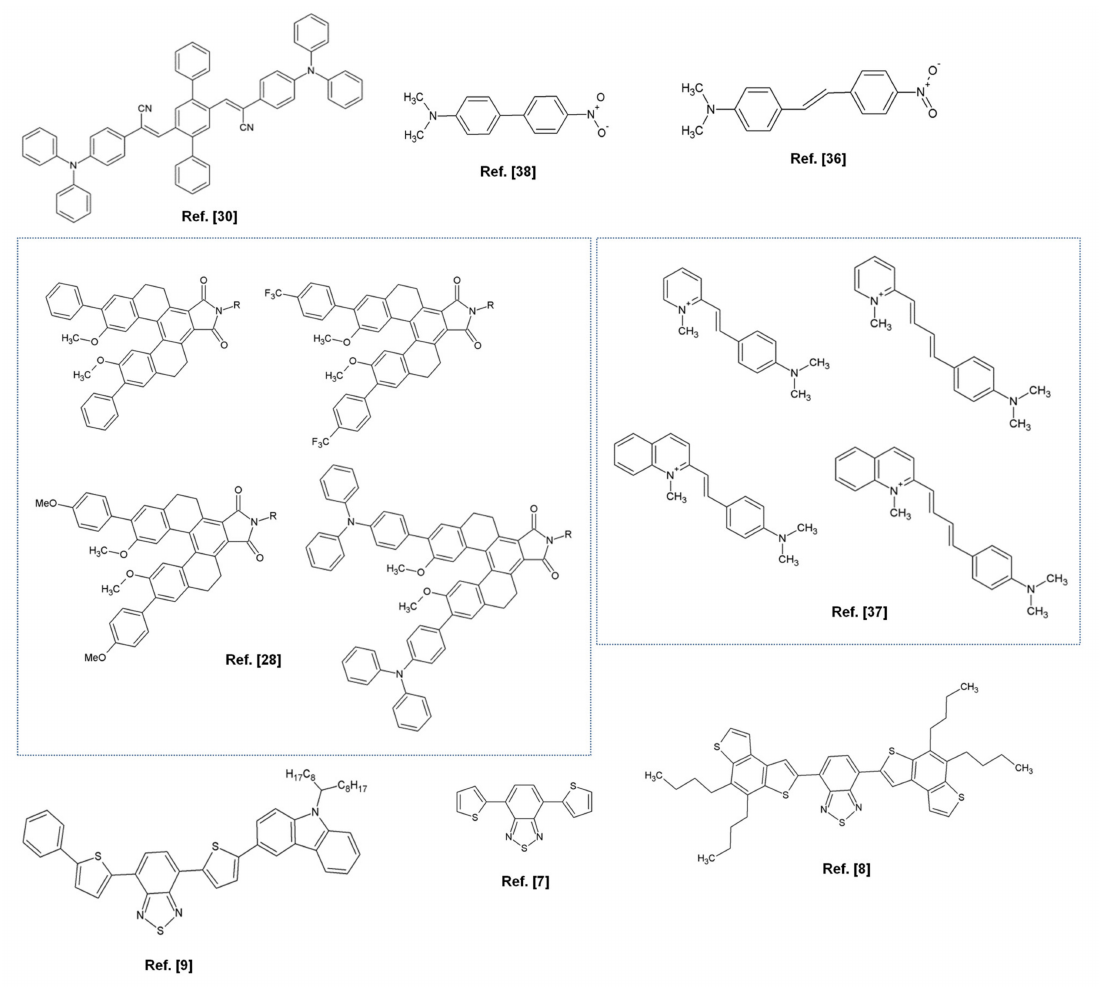
Figure 3. Molecular structures of push-pull systems analyzed in Section 2 with the relative references numbers. In the molecular structures of [28]